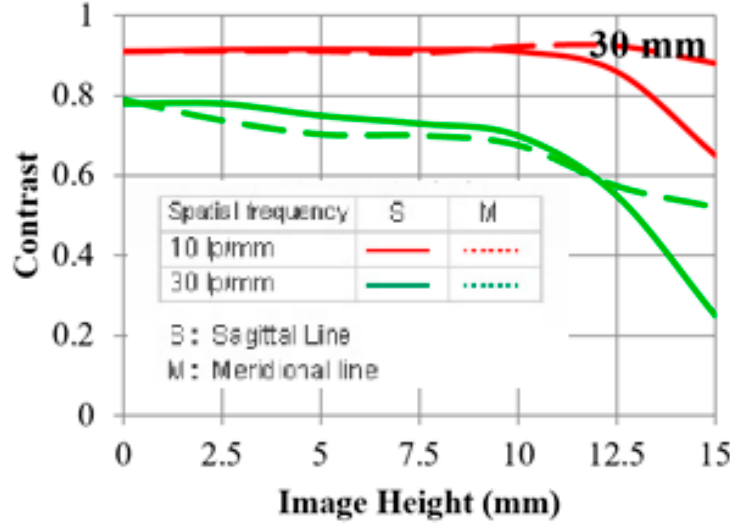
Figure 4. MTF chart 2.